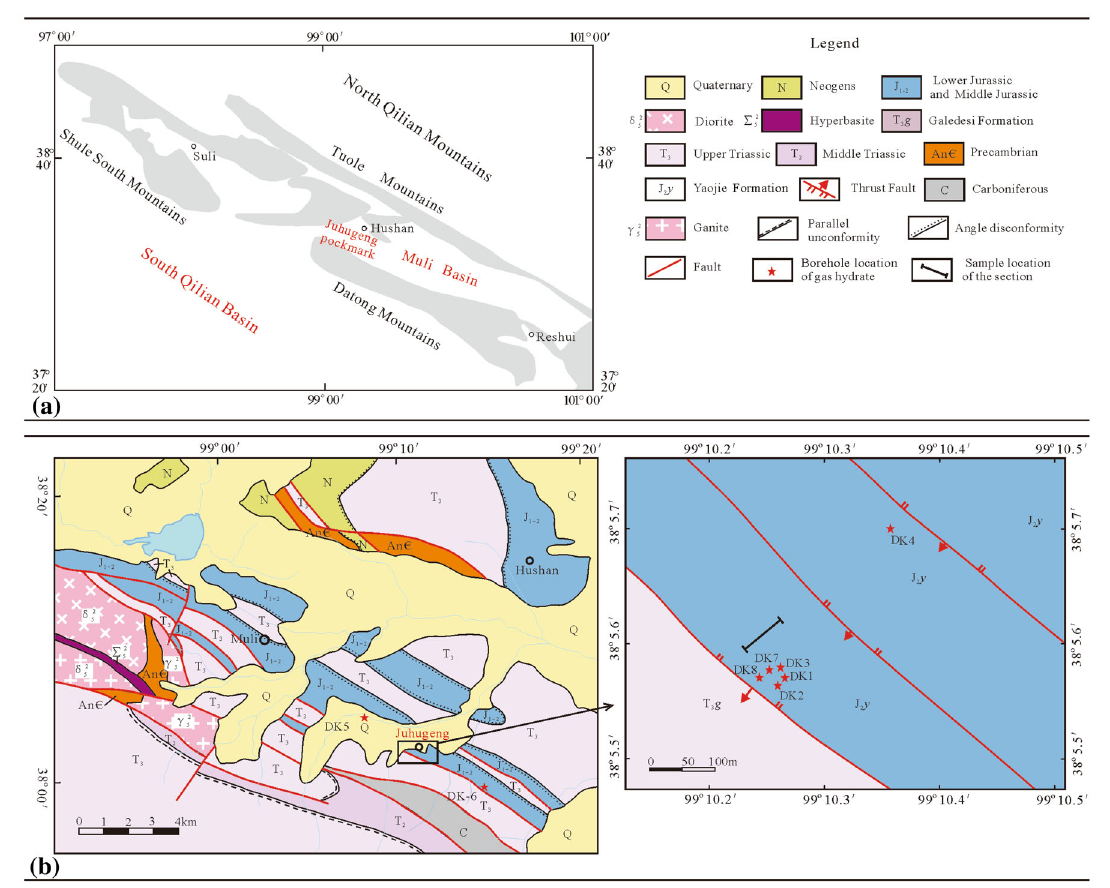
Fig. 1 Location and geological map of the Juhugeng Sag of Muli Basin. a Location of the Juhugeng Sag. b Geological map and wells distribution of gas hydrates in the Juhugeng